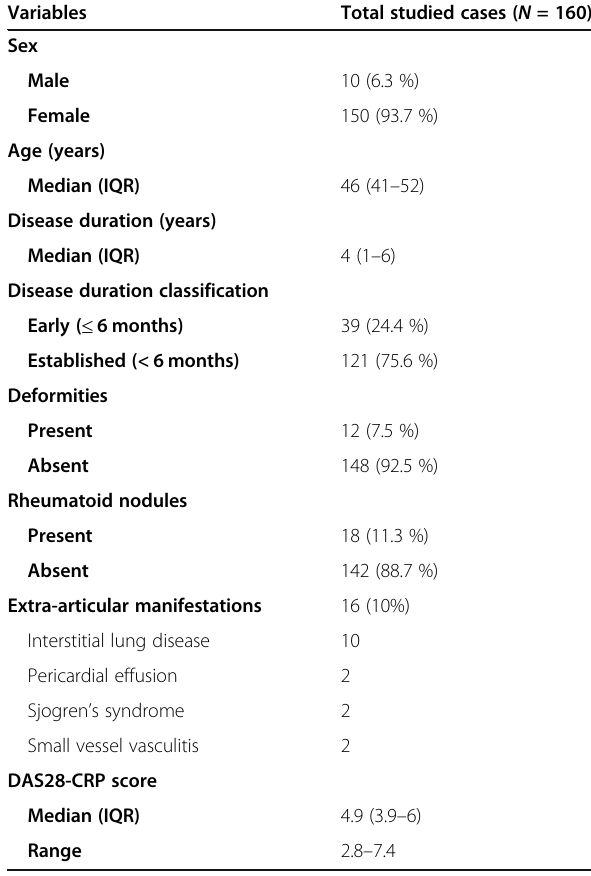
Table 1 Demographic and clinical data of the studied patients Variables